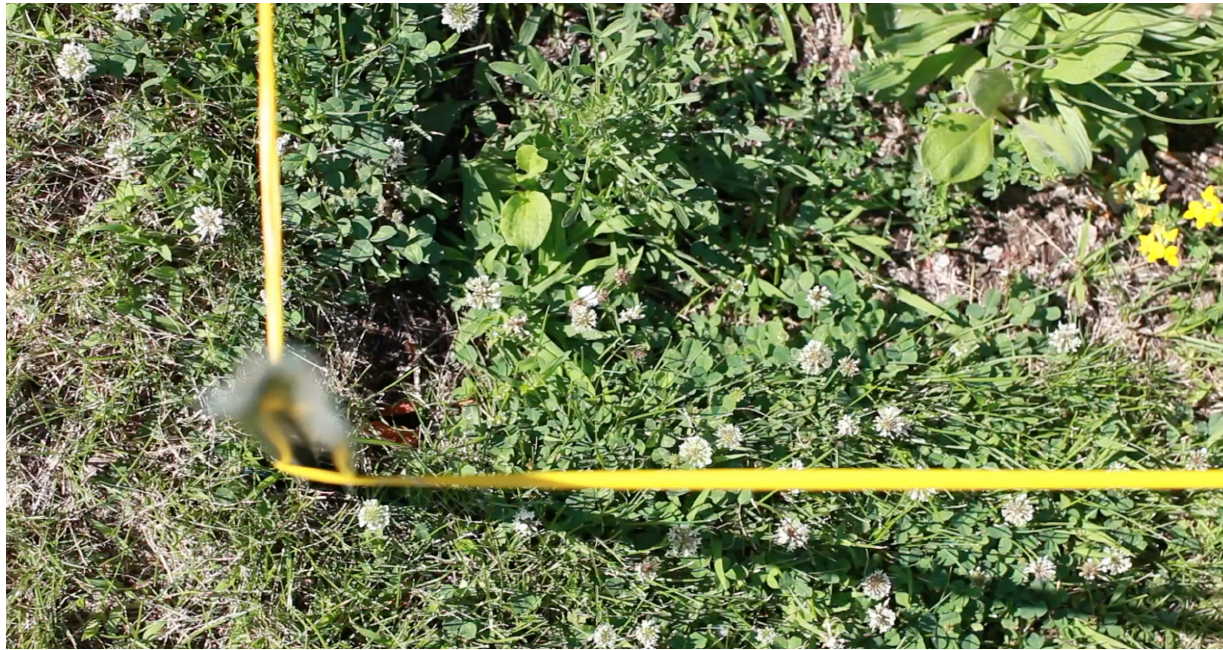
Figure 13: Video documentation of fieldwork at Lawn Lab plot #1 in July 2018, when twelve plant species had been identified in the plot along with a range of insect visitors. Video available at: